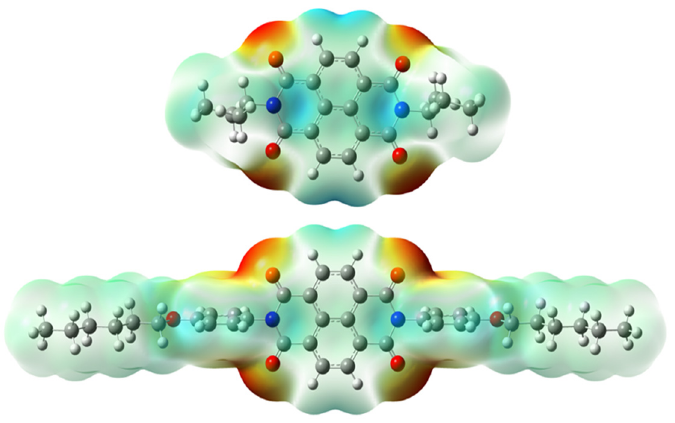
Figure 2. Calculated molecular electrostatic potential surface for NDI-s-Bu ( top ) and NDI-n-OHePh ( bottom ).